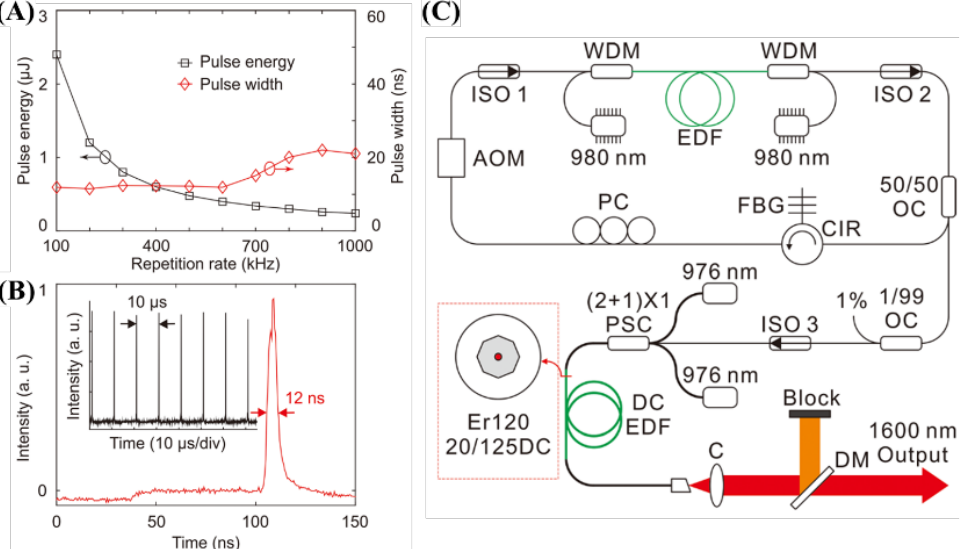
Figure 17. ( A ) Measured energy and width of the output pulse. ( B ) Temporal trace of the output pulse at 100 kHz. ( C ) Schematic of the Q-switched EDFL system. Reprinted from Piao et al . , Appl. Phys. Lett., 2016, 108, 14: 143701 [37], with permission of the American Institute of Physics.